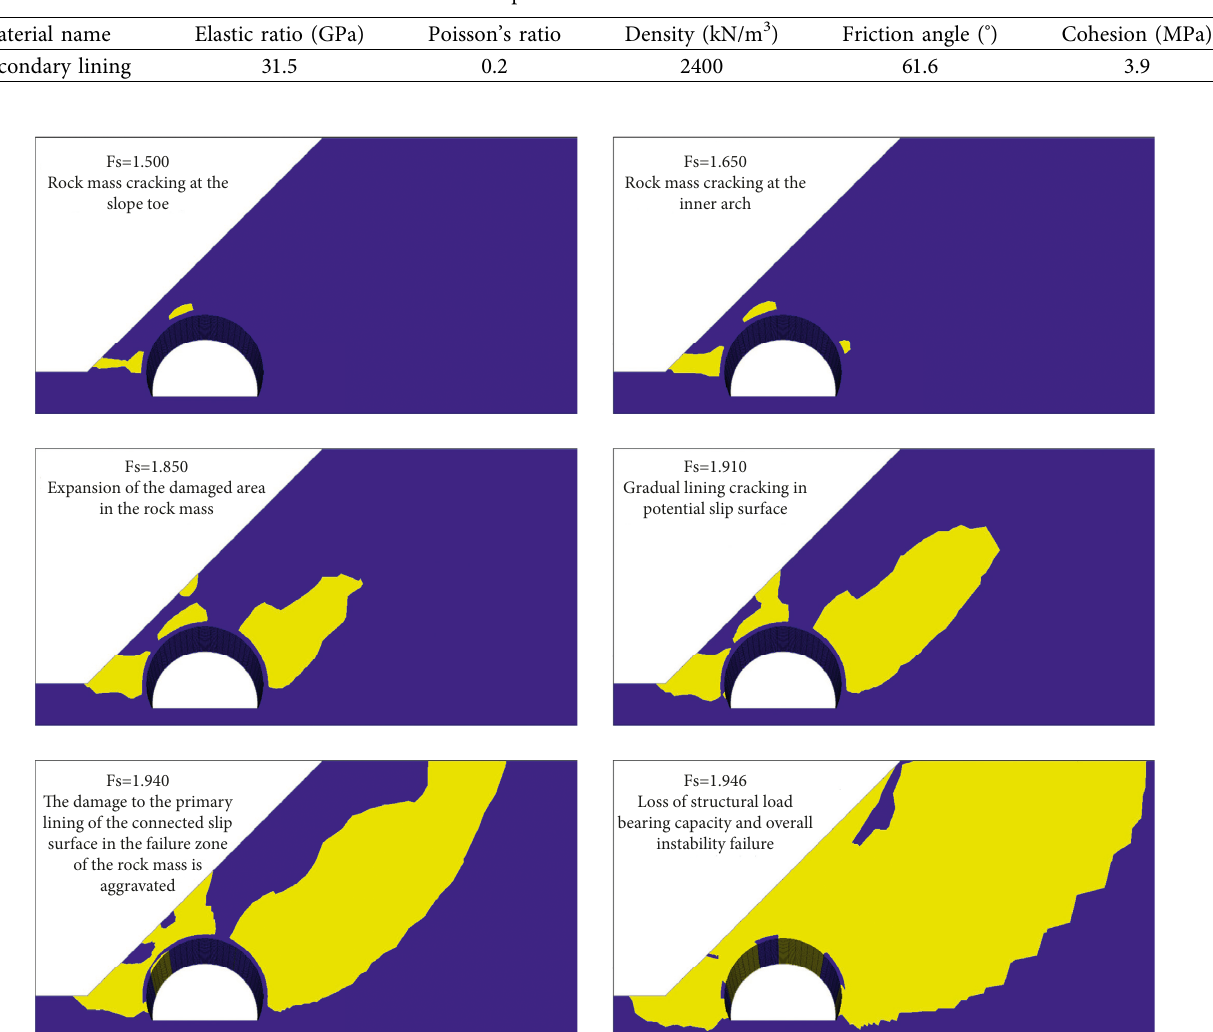
Table 3: Mechanical parameters of C30 concrete calculation.